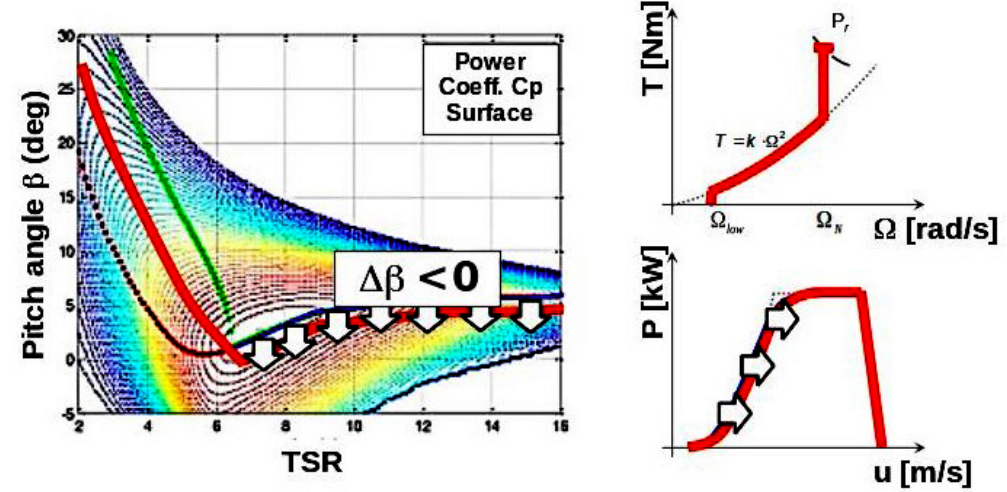
Figure 7. Effect of pitch angle offset toward lower angles in turbine